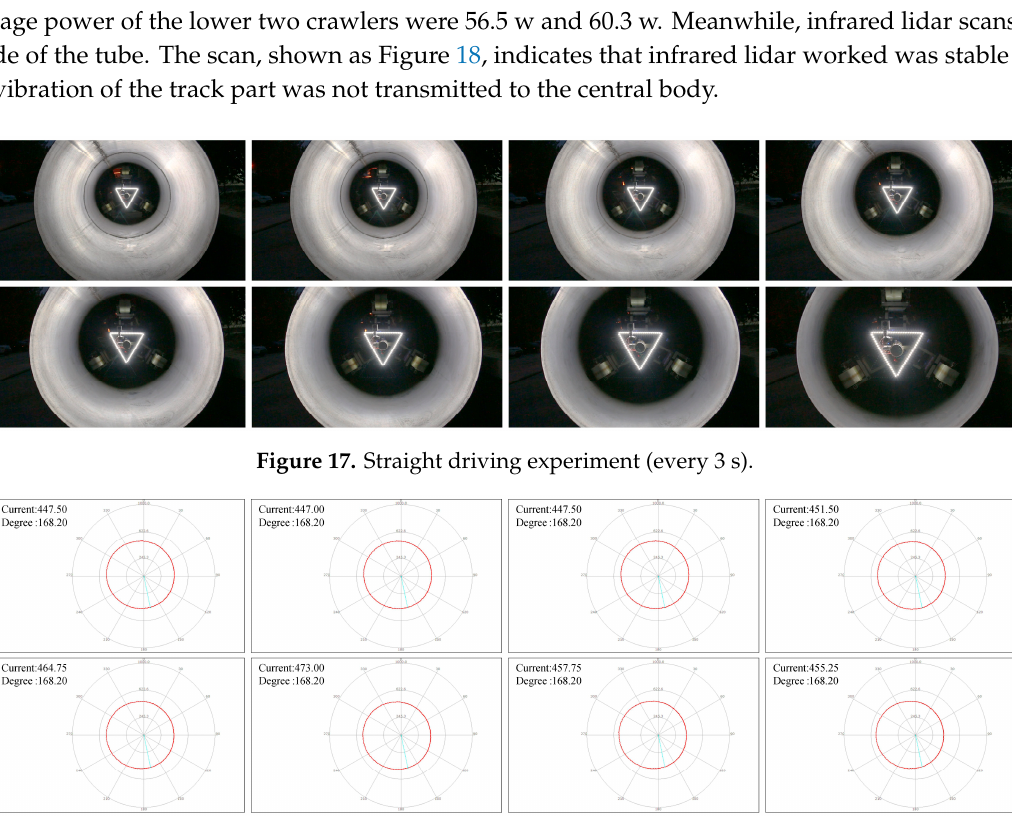
Figure 18. Infrared lidar test data (every 3 s).